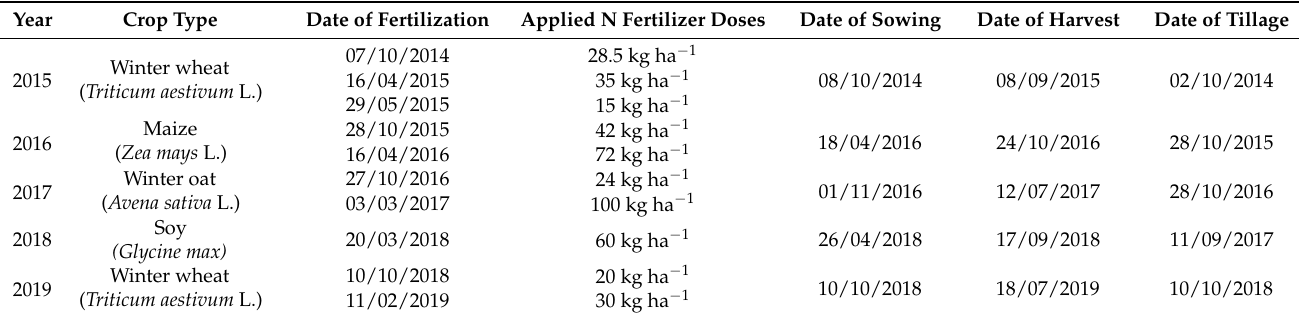
Table 1. Management events and the applied fertilization doses between 2014–2019 [45] (note: weed management is not